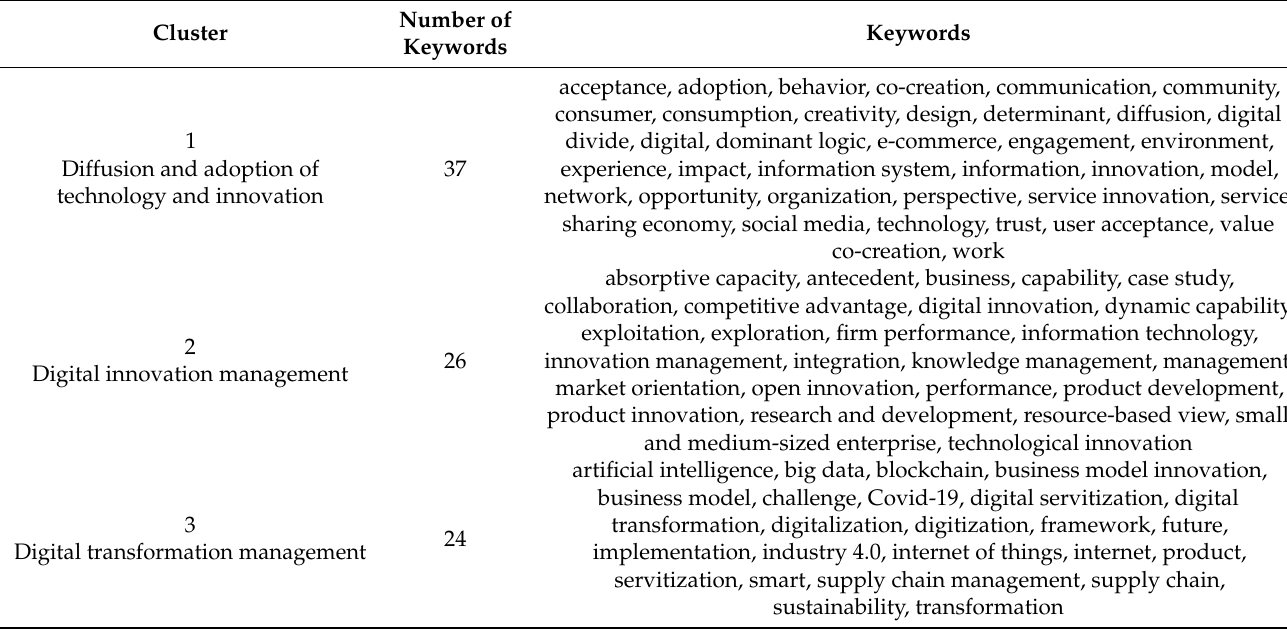
Table 5. Clusters and